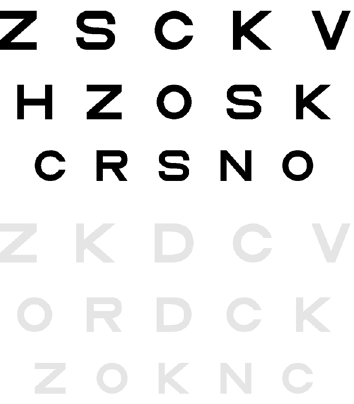
Figure 5. An example of the high (top) and low (bottom) contrast experimental stimuli showing 100% separation between letters. The size of each row of letters differs by 0.05